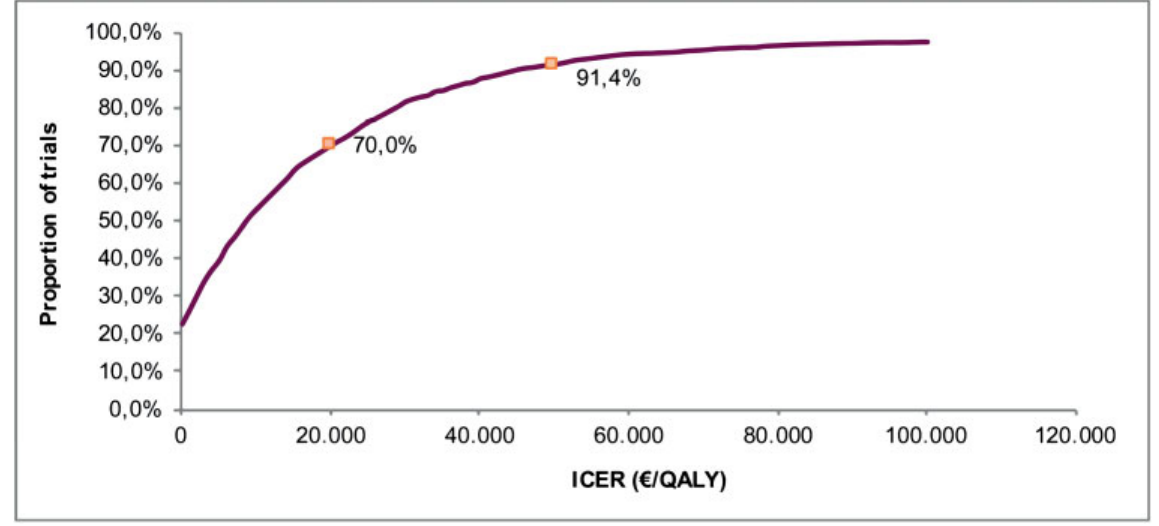
Fig. 2 The cost-effectiveness acceptability curve (CEAC) — base-case analysis. With the probabilities of being cost-effective at a WTP threshold of € 20,000/QALY and € 50,000/QALY. ICER, incremental cost-effectiveness ratio; QALY, quality-adjusted life-year.